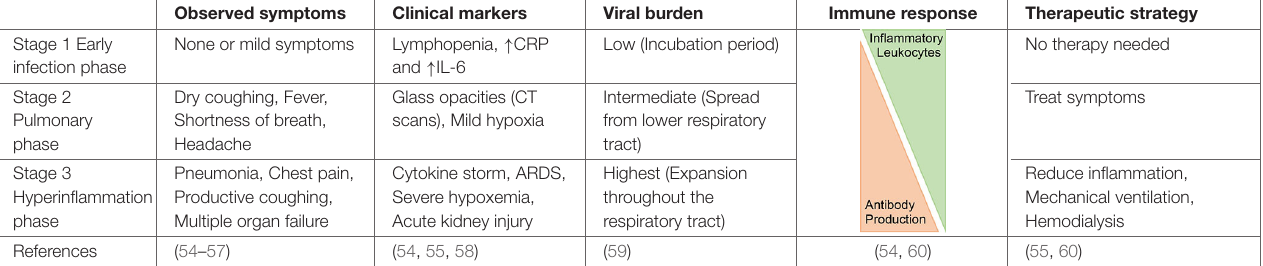
TABLE 2 | COVID-19 pathophysiology.